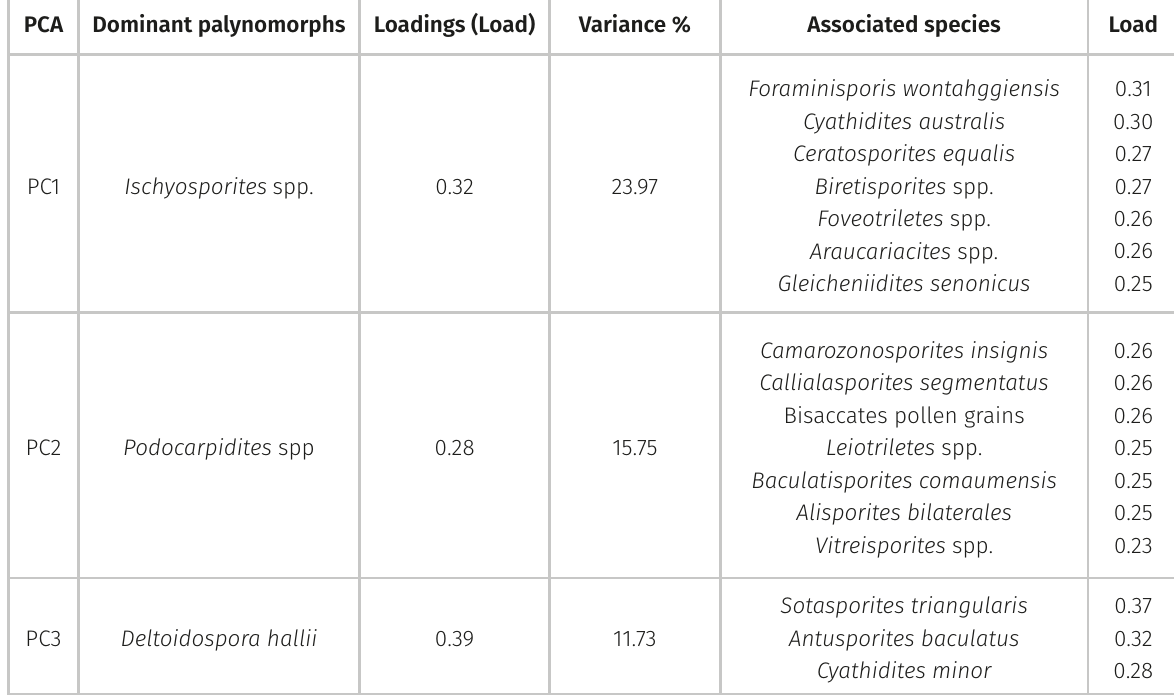
Table II. Principal Component (PC) number, dominant palynomorphs, and associated species with loadings and explained variance in percentage of total variance are